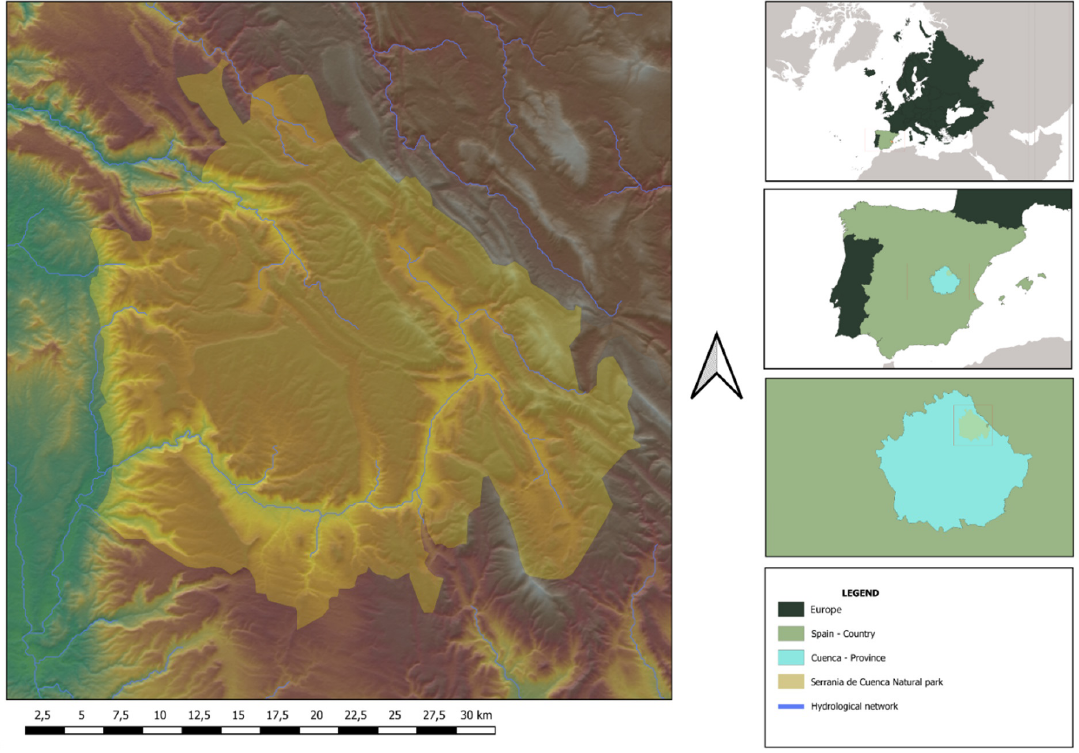
Figure 3. Geographic location of Serranía de Cuenca Natural Park. Source: National Center for Geographic Information (2020).